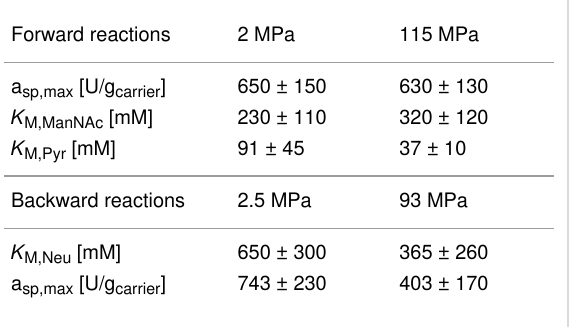
Forward reactions